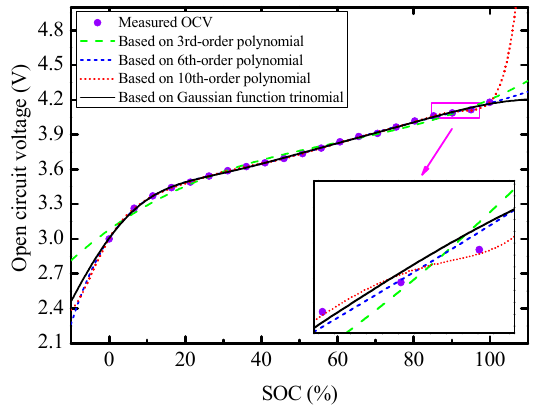
Figure 4. The comparison of OCV curves for different equations.